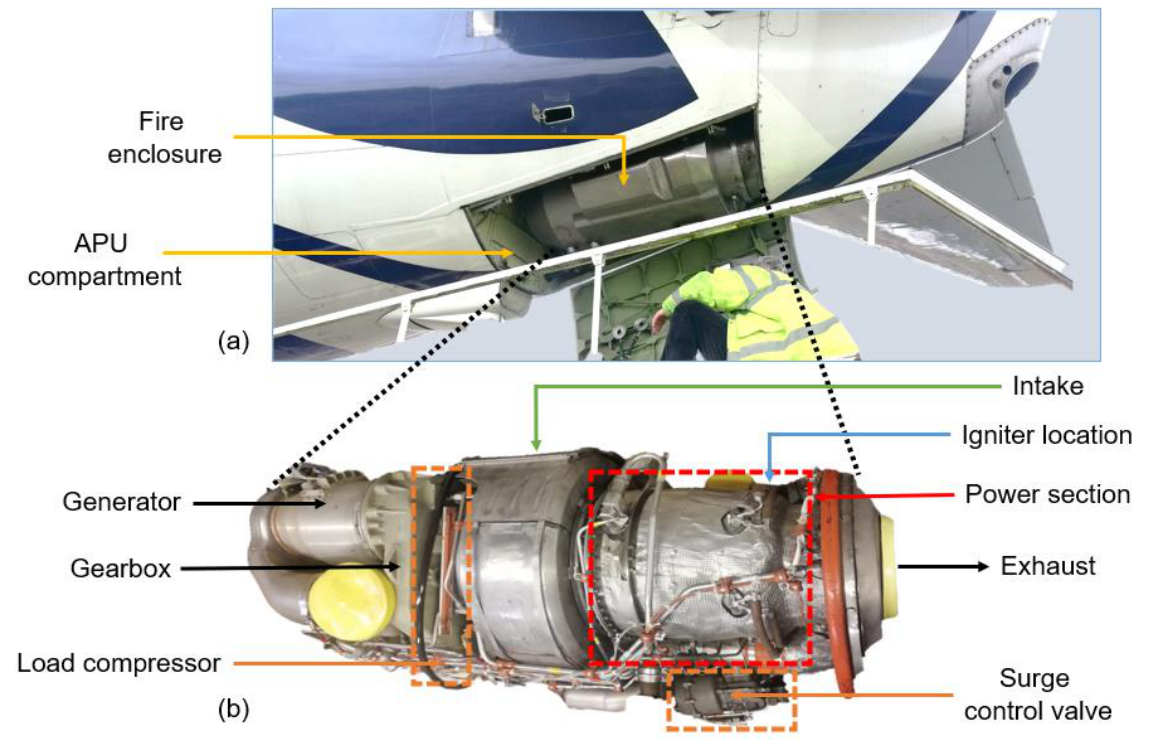
Figure 1. The APU of a Boeing 737-400 ( a ) aircraft tail section and APU compartment; ( b ) components of the APU.